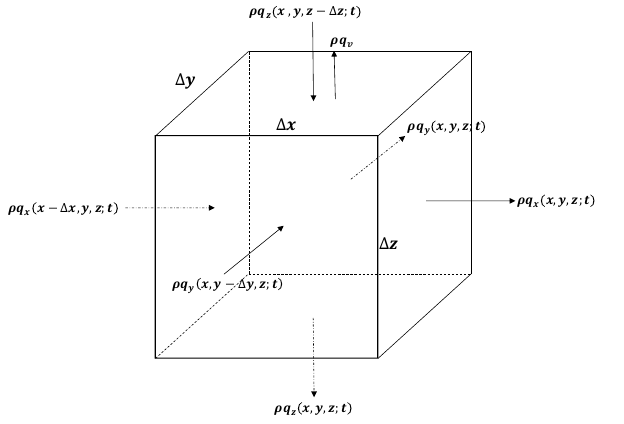
Figure 1. The control volume for the three-dimensional groundwa- ter flow in confined